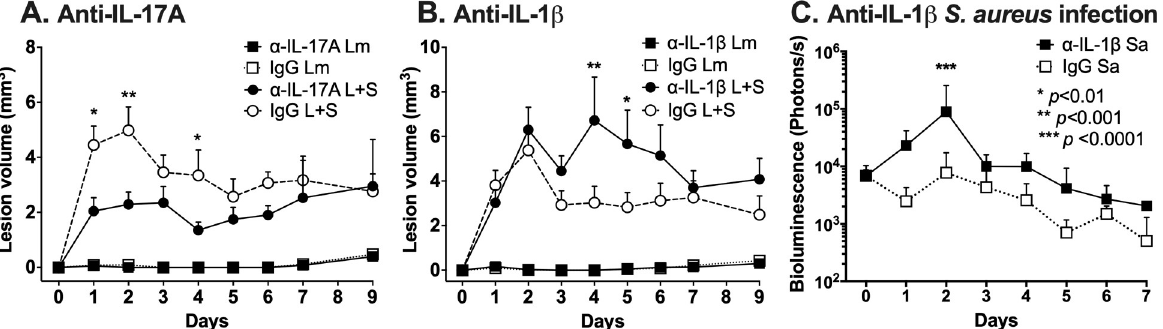
Fig 8. Anti-IL-17A neutralizing antibodies partially ameliorate early coinfection lesion exacerbation while anti-IL-1 β antibodies further exacerbate lesions. Mice were injected intraperitoneally with 0.5 mg neutralizing antibody or isotype control antibody one day prior to intradermal ear injection with L . major (Lm) or L . major and S . aureus (L+S). Neutralizing antibody was administered one day prior to infection and every three days for 9 days. Ear lesion volumes during coinfection in mice treated with (A) anti-IL-17A or MOPC-21 isotype antibodies, or (B) anti-IL-1 β or polyclonal Armenian hamster IgG isotype antibodies are shown. Data represent the mean ± SEM of two independent experiments, each with 5 mice per group. IgG L+S versus anti-IL-17A L+S or anti-IL-1 β L+S comparisons: � p < 0.01, �� p < 0.001, ��� p < 0.0001 by two-way ANOVA with Tukey’s post-test. (C) Bacterial load by in vivo bioluminescence imaging of mice treated with anti-IL-1 β or polyclonal Armenian hamster IgG isotype antibodies and infected with 10 4 CFU S . aureus LAC:: lux alone. Data represent the mean ± SD of one experiment with 5 mice per group. ��� p < 0.0001 by two-way ANOVA with Tukey’s post-test.